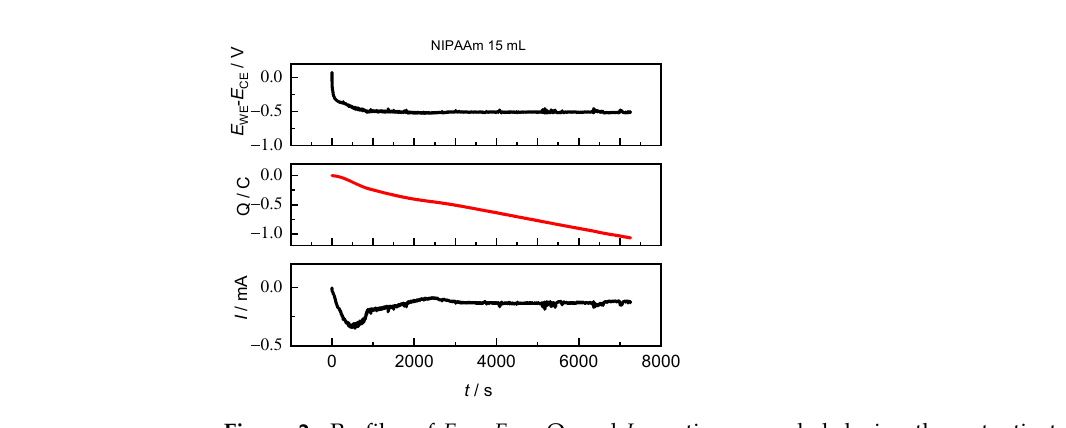
Figure 2. Profiles of E WE - E CE , Q, and I vs. time recorded during the potentiostatic se ATRP of 10 wt% AAm, HEAAm, and NIPAAm in H 2 O +0.1 M NaBr + 0.05 M SP at T = 0 °C. E app = E pc . Working electrode = Pt mesh, counter electrode = Al wire. Both WE and CE have ~6 cm 2 surface area. V = 15 mL. Substrate is cellulose(H)-BriB.